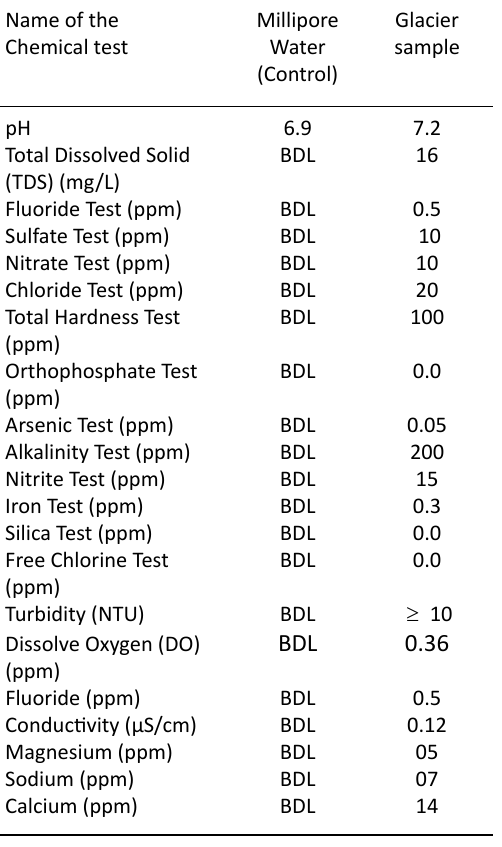
Table 1. Physicochemical Analysis of glacier sample